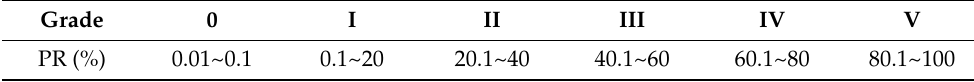
Table 1. Rating sheet of repellency.